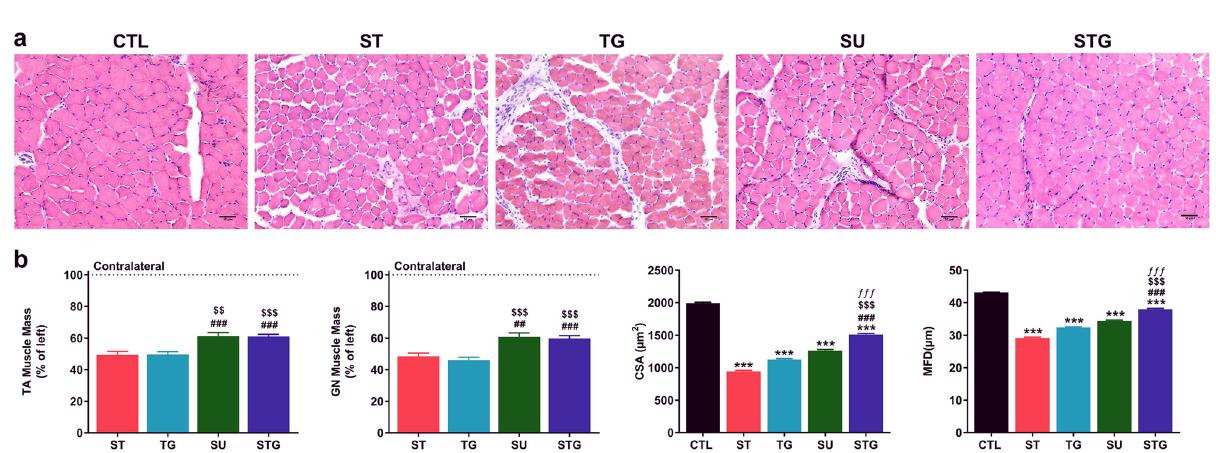
Figure 5. Effect of different transection models on TA muscle histology, muscle mass, and quantitative measurements of the muscle fibers. ( a ) Representative images of TA muscle cross sections stained with H&E. Scale bar, 50 µm (at lower right corner); magnification 20 ×. ( b ) TA muscle mass as % of left side, n = 10–12/ group; CSA of TA muscle as µm 2 , n = 3/group; and MFD of TA muscle as µm, n = 3/group. *** P < 0.001 vs. CTL, ### P < 0.001 vs. ST, $$ P < 0.01, $$$ P < 0.001 vs. TG, and ƒƒƒ P < 0.001 vs. SU. For other details, see Fig.